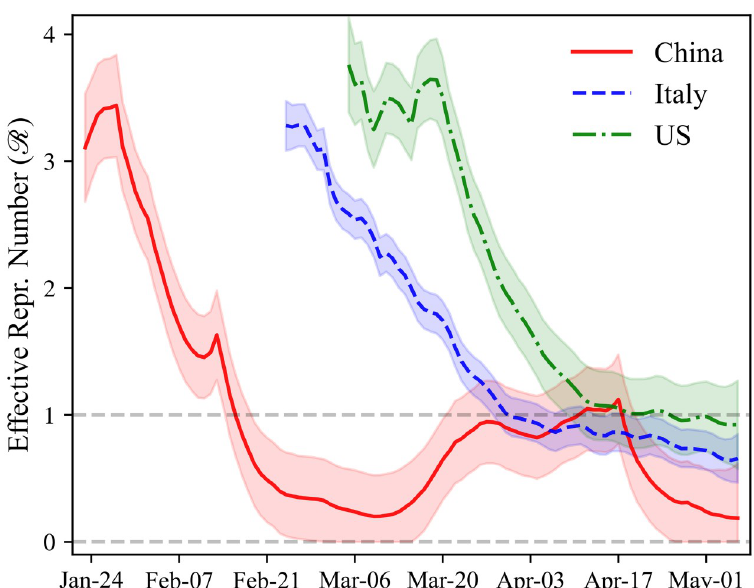
Fig 1. R of COVID-19: China, Italy, and the US. Estimates of the effective reproduction rate ( R t selected countries. The sample consists of all dates after the total number of reported cases in the country has reached 100. 65% credible bounds shown by the shaded areas.